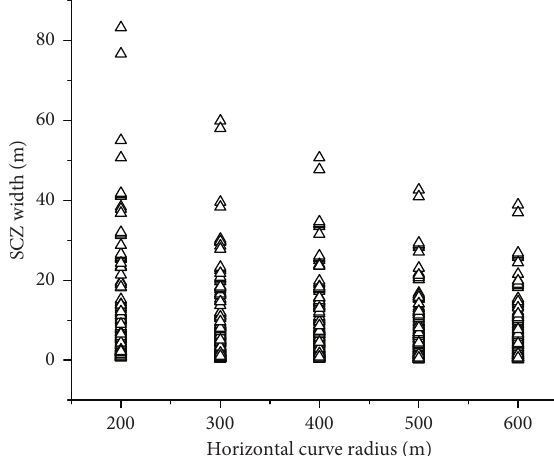
Figure 9: Distribution of l among different vehicle types.